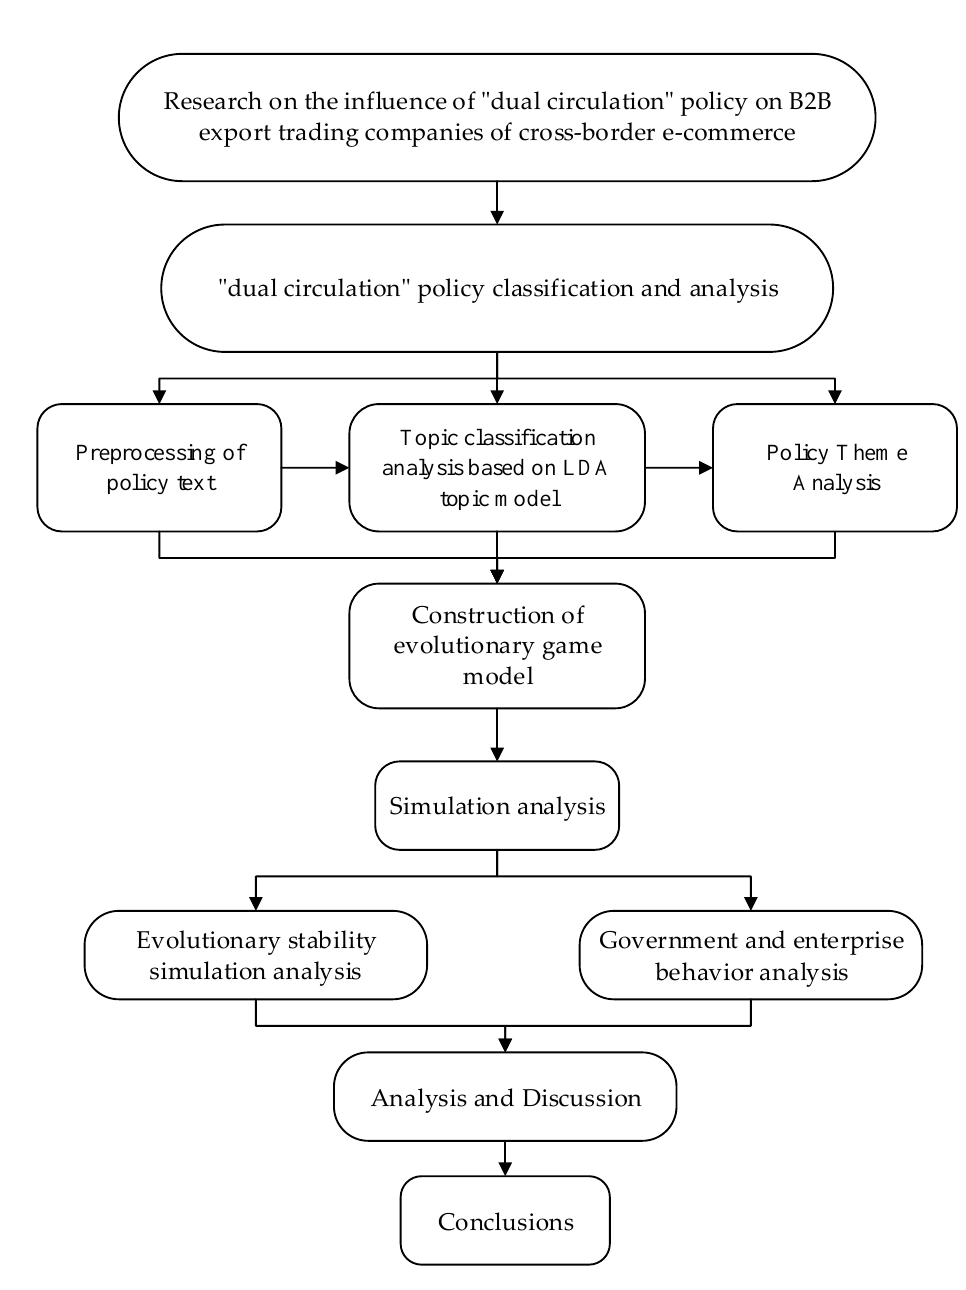
Figure 1. Research framework of this paper.